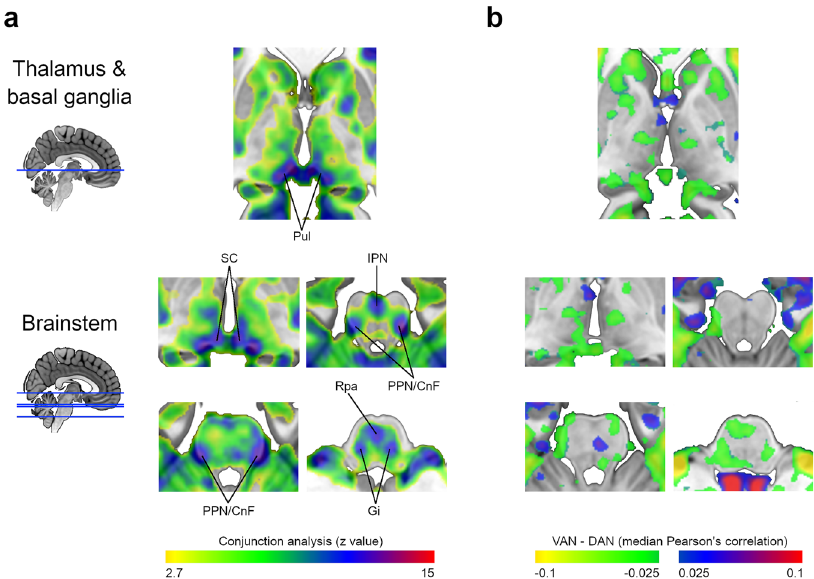
Fig. 2 VAN and DAN maps similarity. a Conjunction analysis of the VAN and DAN statistical maps at the thalamus, basal ganglia, and brainstem levels ( n = 110). b Difference map resulting from the subtraction of the median DAN Pearson ’ s correlation map from the VAN. CnF cuneiform nucleus, DAN dorsal attention network, Gi gigantocellular nucleus, IPN interpeduncular nucleus, PPN pedunculopontine nucleus, Pul pulvinar, Rpa raphe pallidus nucleus, SC superior colliculus, VAN ventral attention network. (see maps at